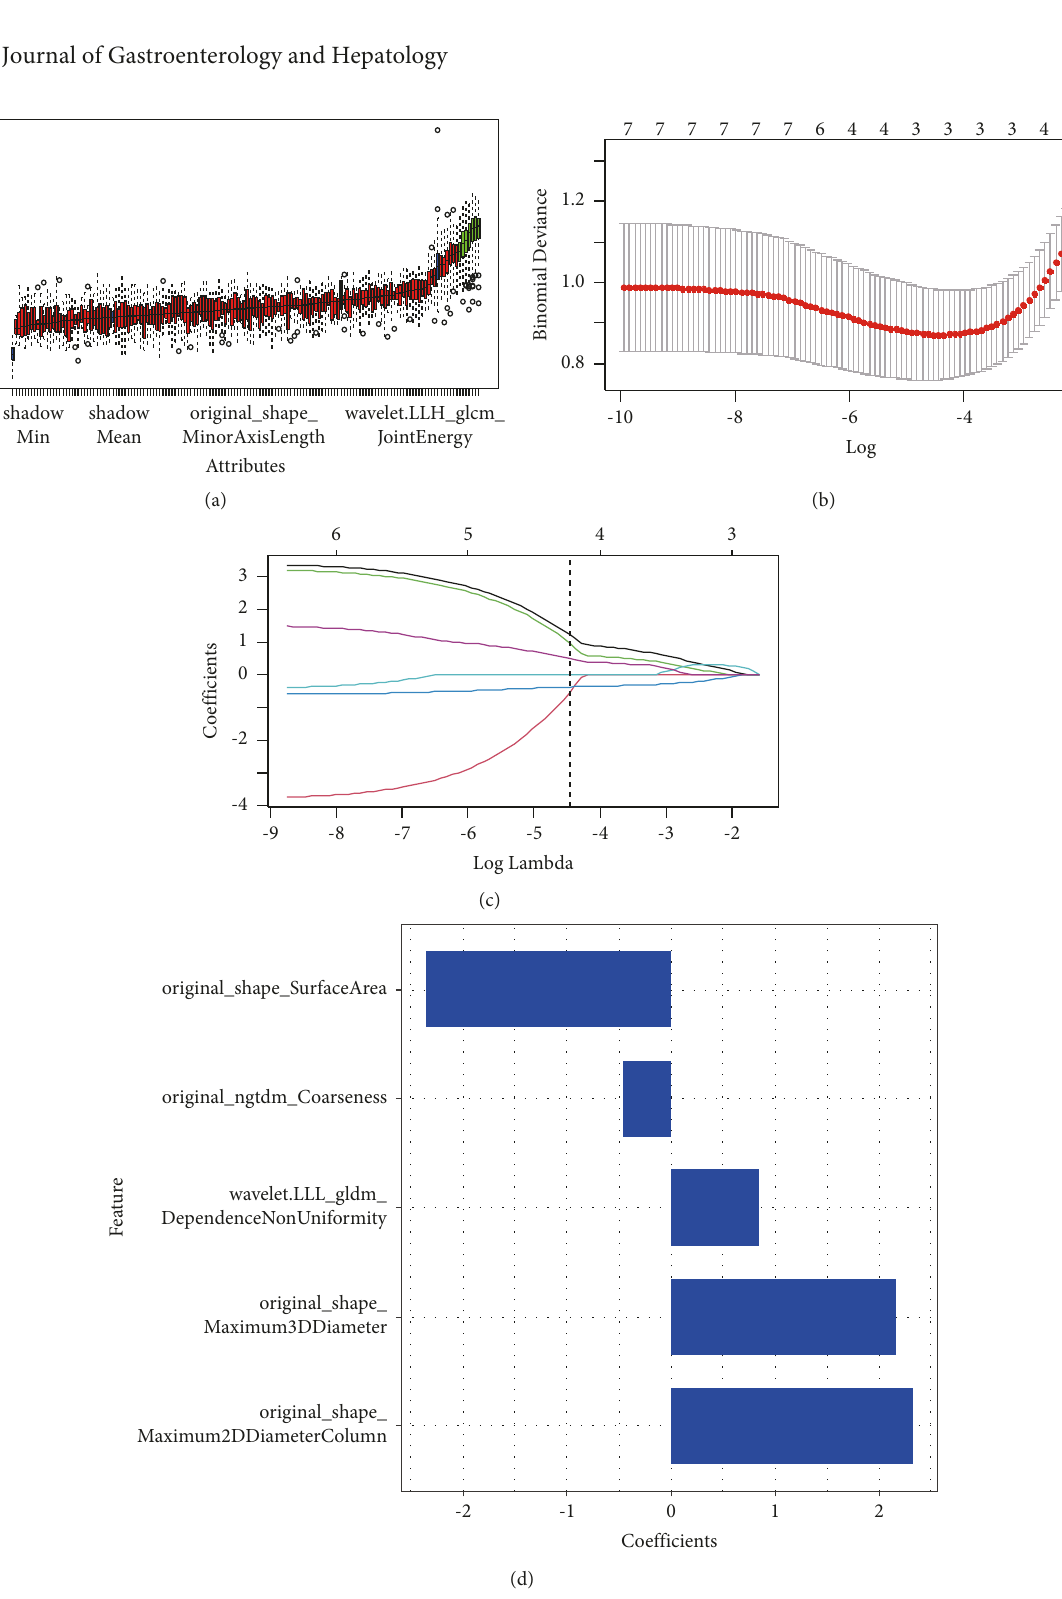
Figure 2: Result of feature selection of boruta and least absolute shrinkage and selection operator (LASSO) for significant fibrosis ( F ≥ 2). (a) Importance and attributes of significant fibrosis ( F ≥ 2) in boruta. Red represents the rejected attribute and green is the confirmed attribute. Blue represents uncertain attributes. (b), (c) The bottom X -axis represents the value of log ( λ ), while the upper X -axis represents the number of nonzero parameters. A dotted vertical line was drawn at the optimal values by using the minimum criteria with ( λ ) 0.00416. (d) Coefficient of the most predictive